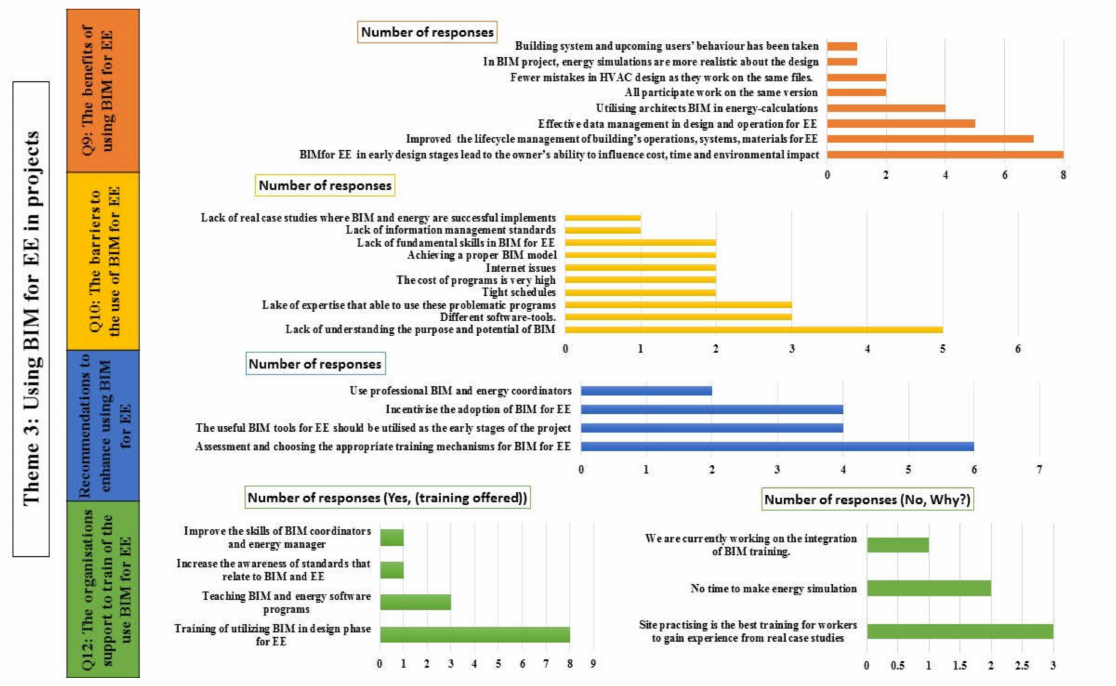
Figure 12. The number of responses for using BIM for EE in